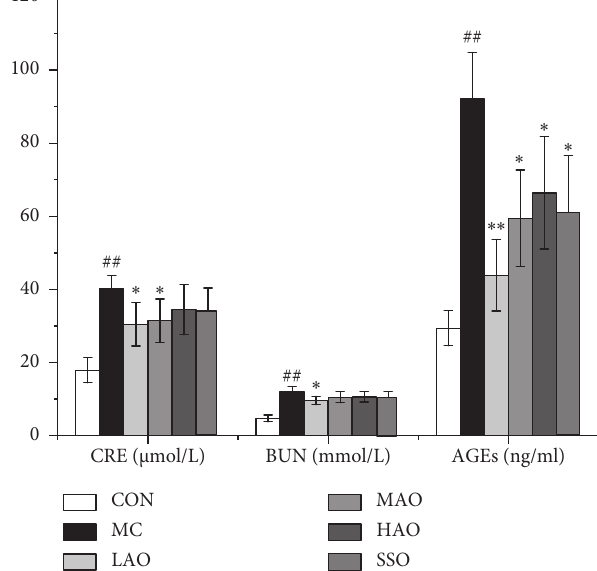
Figure 6: Effects of almond oil on serum CRE, BUN, and AGEs in STZ-induced rats. CRE, creatinine; BUN, blood urea nitrogen; AGEs, advanced glycation end products. Data were expressed as means ± SD. The MC group compared with the CON group, # P < 0 . 05, ## P < 0 . 01; the LAO, MAO, HAO, and SSO groups compared with the MC group, ∗ P < 0 . 05, ∗∗ P < 0 . 01.